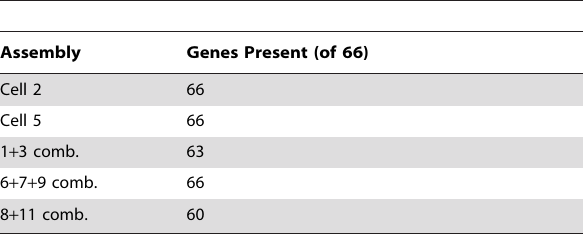
Table 3. Core gene presence in Tannerella BU063 genome assemblies.